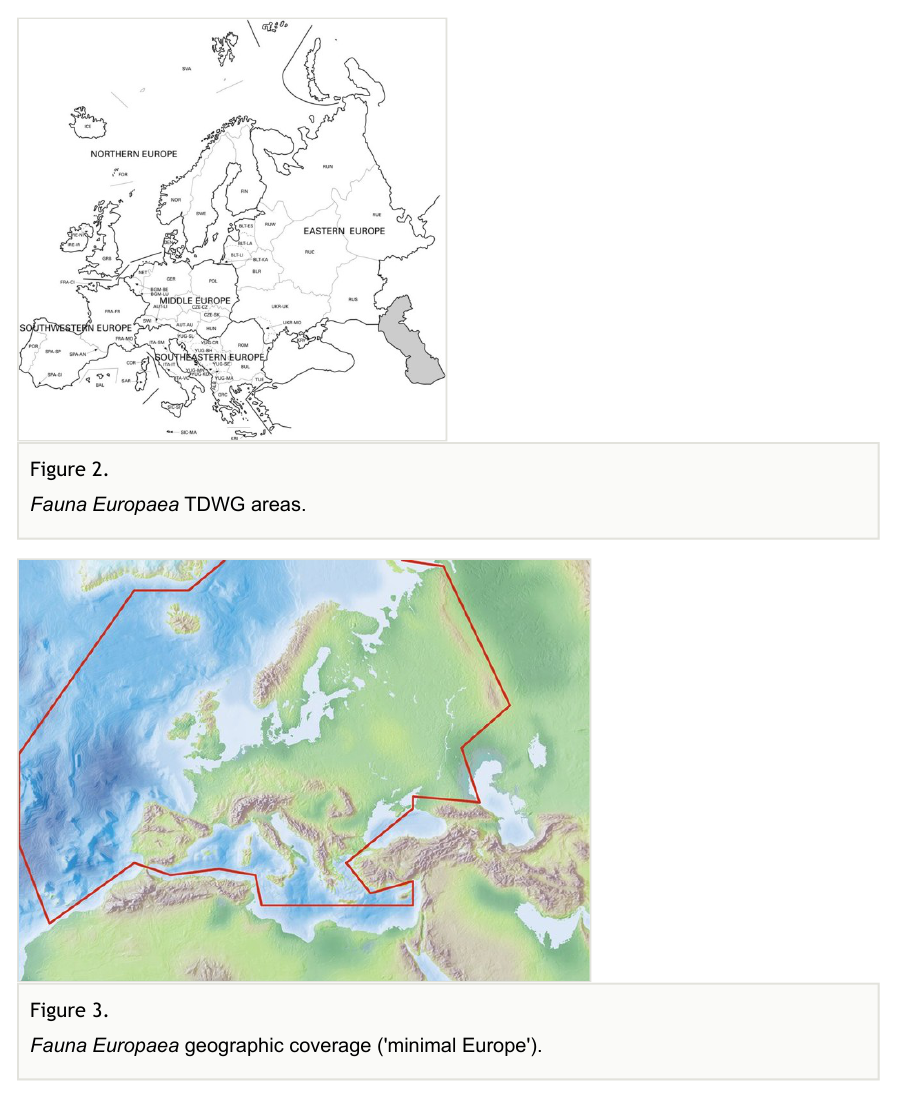
synonyms, and (4) the correct nomenclature. The Fauna Europaea 'Guidelines for Group